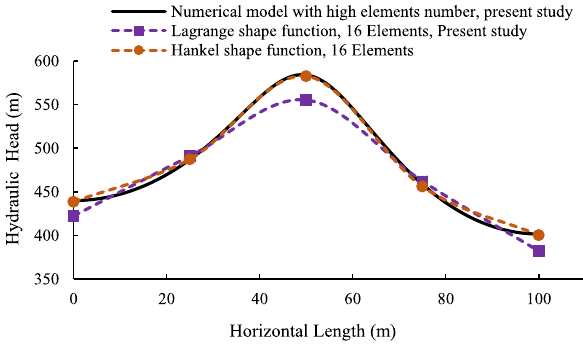
Fig. 13 Comparison of hydraulic head results at y = 25 m, among Hankel shape function (16 elements) and Lagrange shape function (16 and 5000 elements) for the third